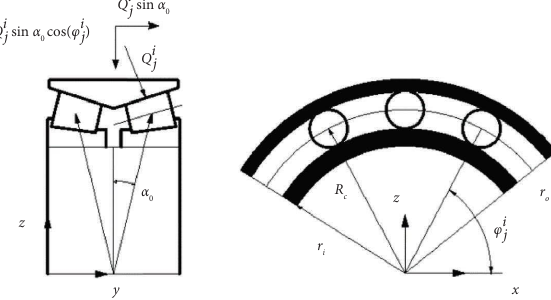
Figure 4: Bearing contact element